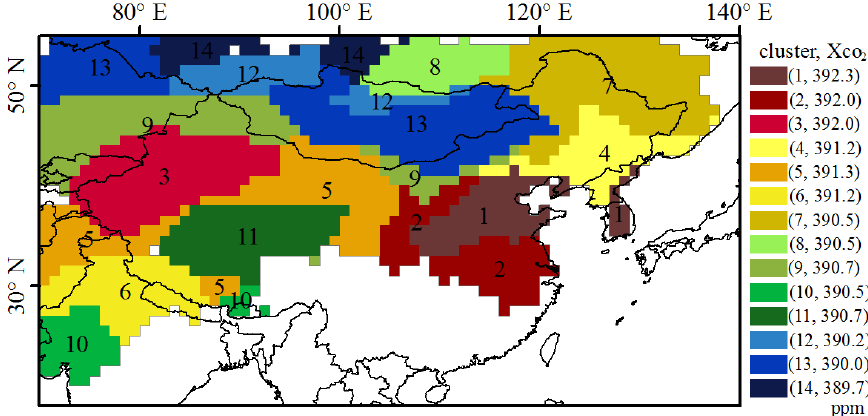
Figure 3. Clustering result based on S-Xco dataset with 14 clusters and the corresponding 2 cluster-averaged Xco data from 2010 to 2